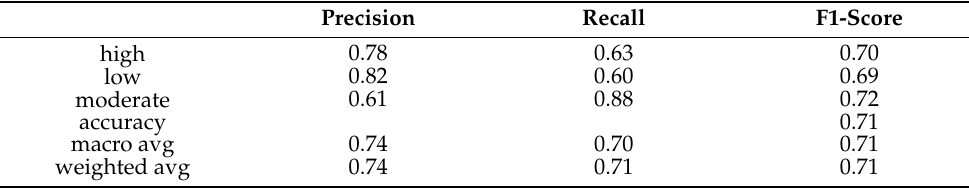
Figure 3. Confusion matrix, accuracy, and loss function for the total dataset (KOA mild and moderate) for the three levels of FOF. Table 5. Performance metrics for three classes of FOF for the total